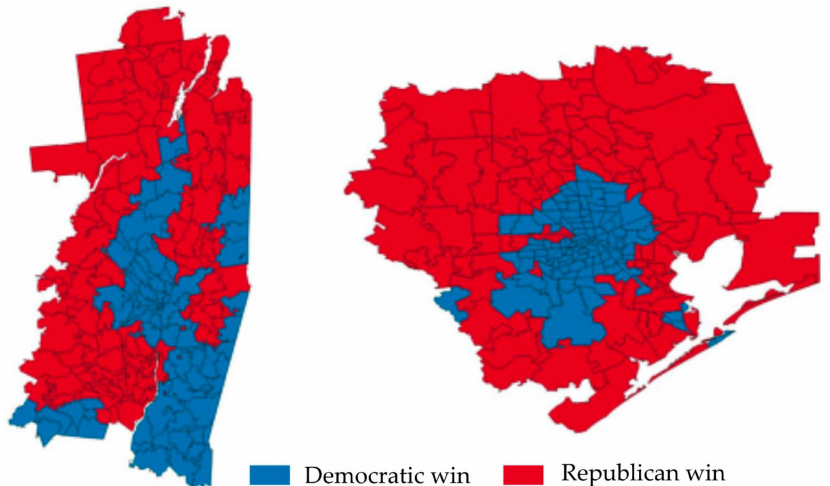
Figure 2. Presidential election results in 2022 at the ZCTA level in the Capital Region ( left ) and Houston Metro ( right